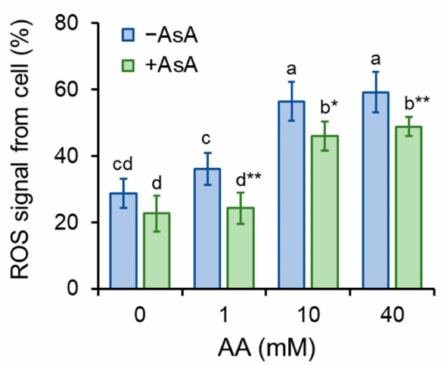
Figure 4. ROS generation. AA-induced enhancement of ROS formation detected as enhancement of fluorescence signal was compared to the control group w/o AA addition and to the group of cells pre-treated with AsA. Individual bars represent mean ± SD of 8 individual samples and two independent experiments. Statistical significance is determined by Duncan’s post-hoc test, different letters above bars indicate statistical difference as p < 0.05 *, 0.01